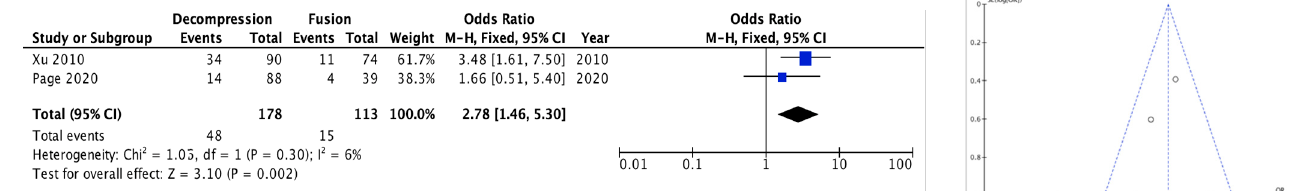
Figure A9. Re-operation.